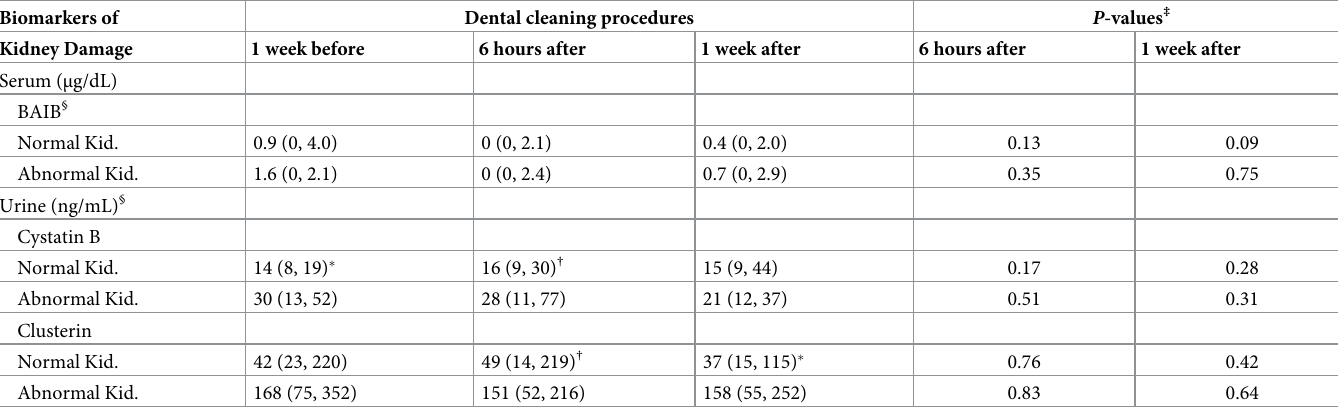
Table 8. Serum and urine kidney tissue damage biomarkers before and after general anesthesia and dental cleaning procedures in cats and dogs with periodontal disease stratified by abnormal kidney function biomarkers prior to procedure (n = 62) � . Biomarkers of Dental cleaning procedures P -values